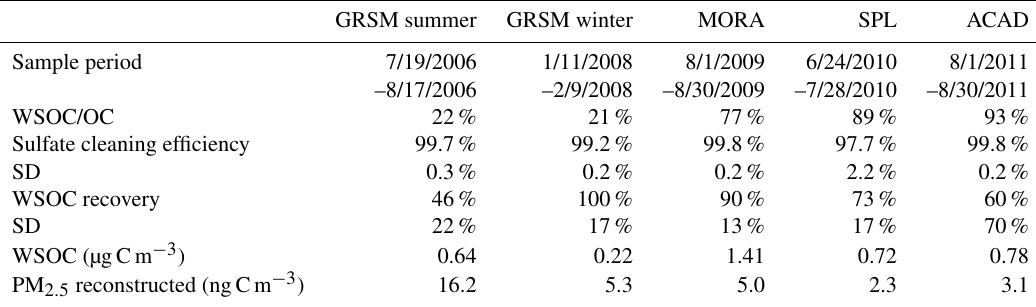
Table 1. Project